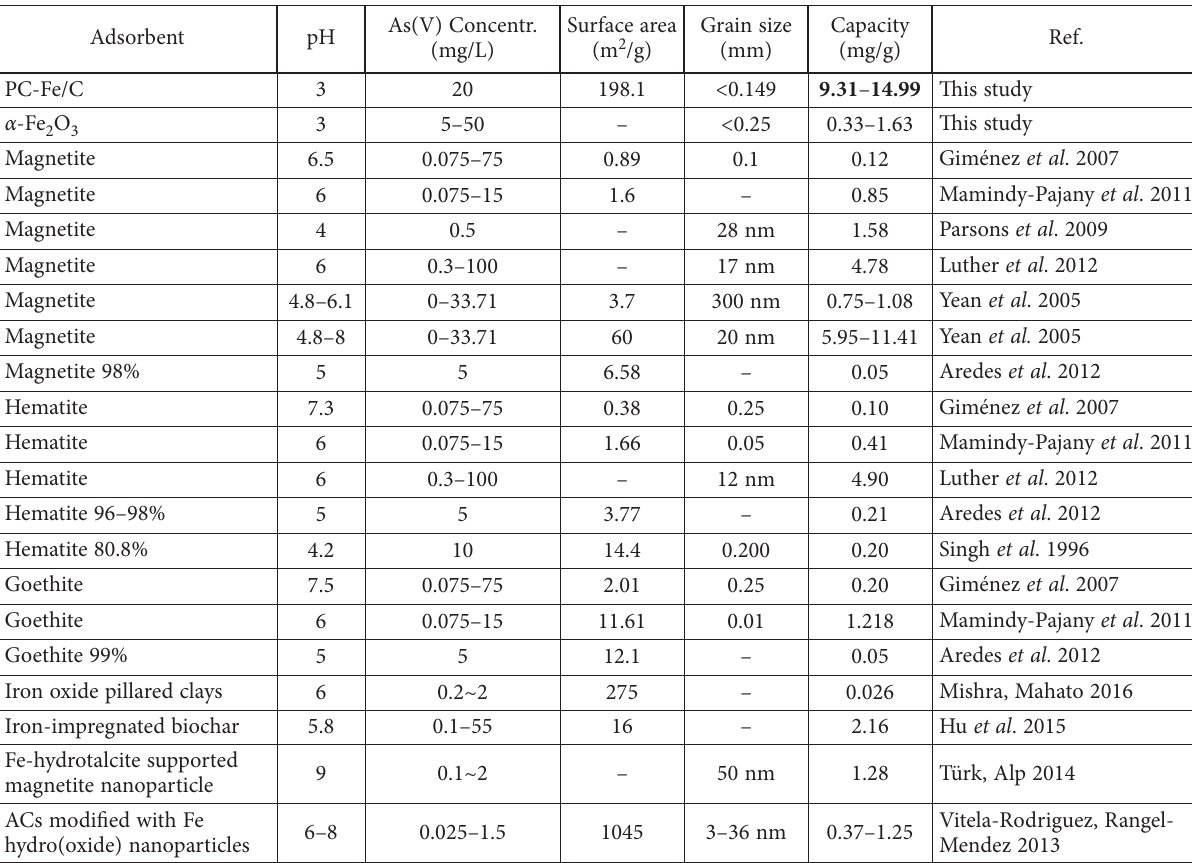
Table 3. Comparison of adsorption capacity of the PC-Fe/C adsorbent with some iron oxides for As(V) removal